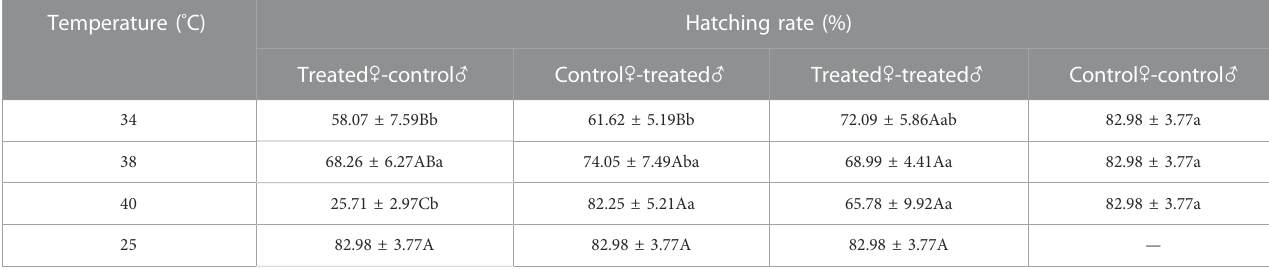
TABLE 6 The hatching rate of the eggs of Z. tau adults exposed to different high-temperature treatments for 12 h. Temperature ( °